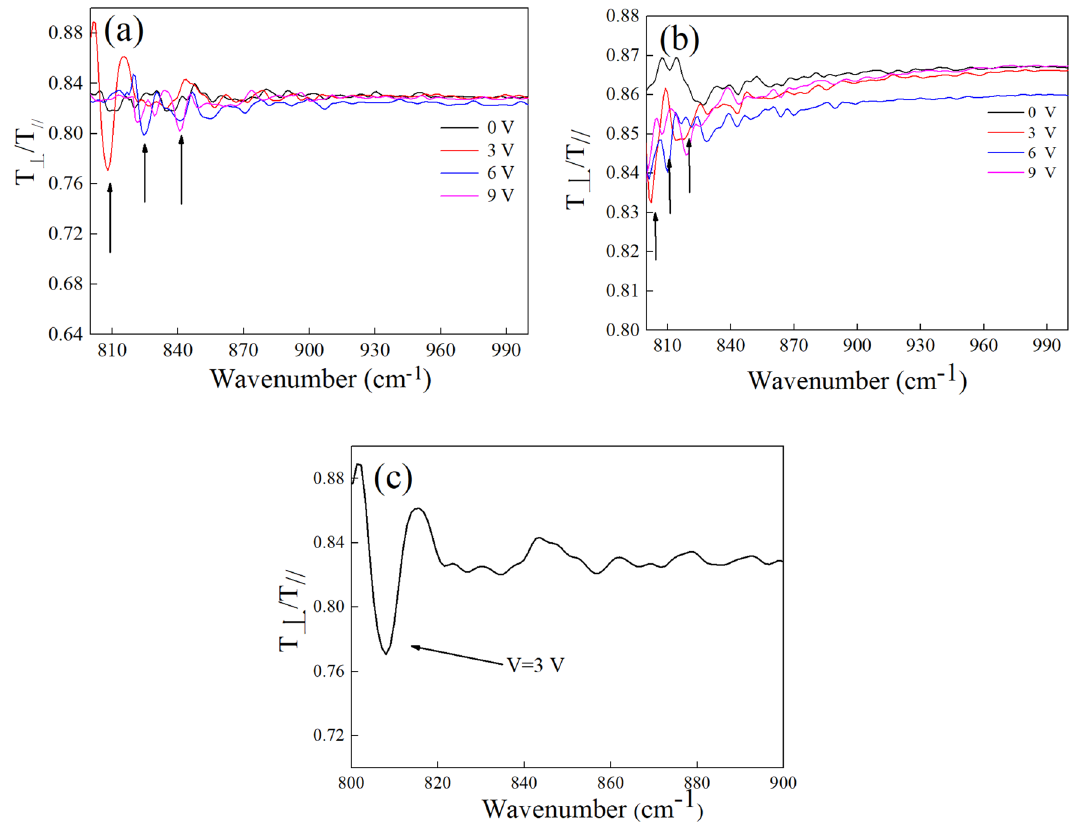
Figure 4. The transmission spectra at different voltage of the sample ( a ) with a period of 12 um ( b ) with a period of 14 um ( c ) the maximum ER of the sample is about